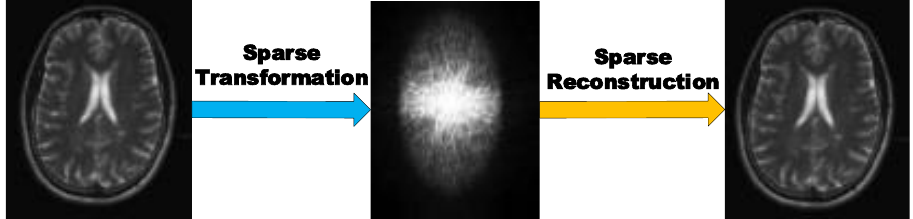
Figure 1. Application of Compressed Sensing in Magnetic Resonance Images (MRI)